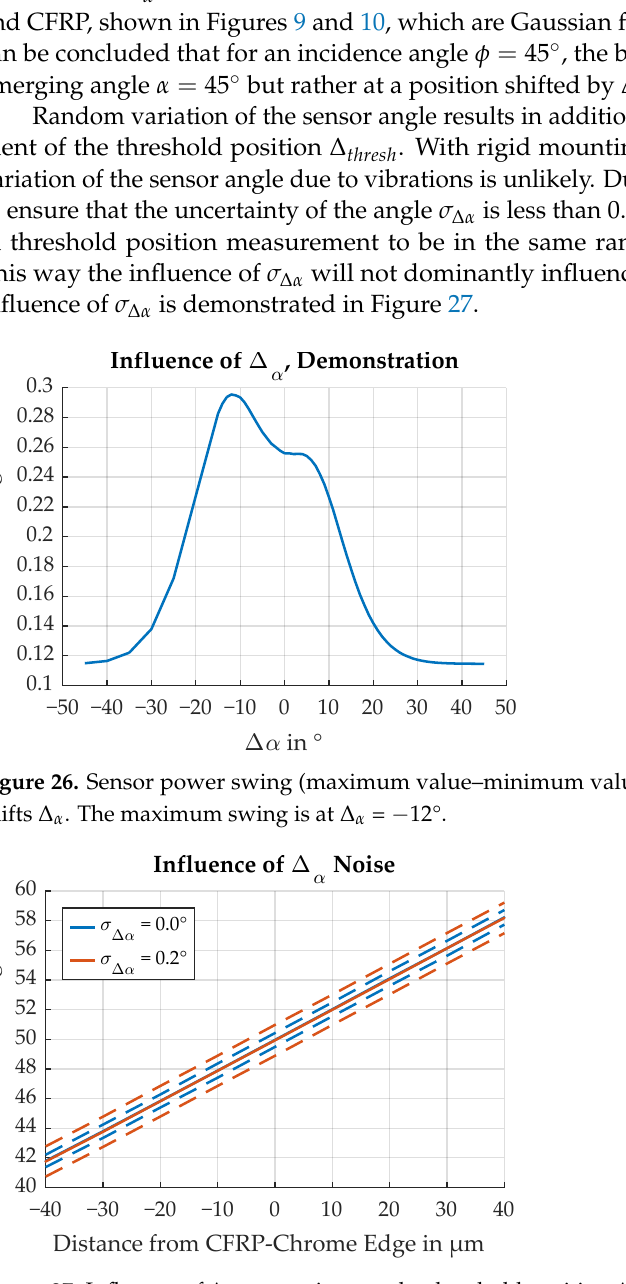
Figure 27. Influence of ∆ α uncertainty on the threshold position ∆ thresh . Dotted lines represent ± σ